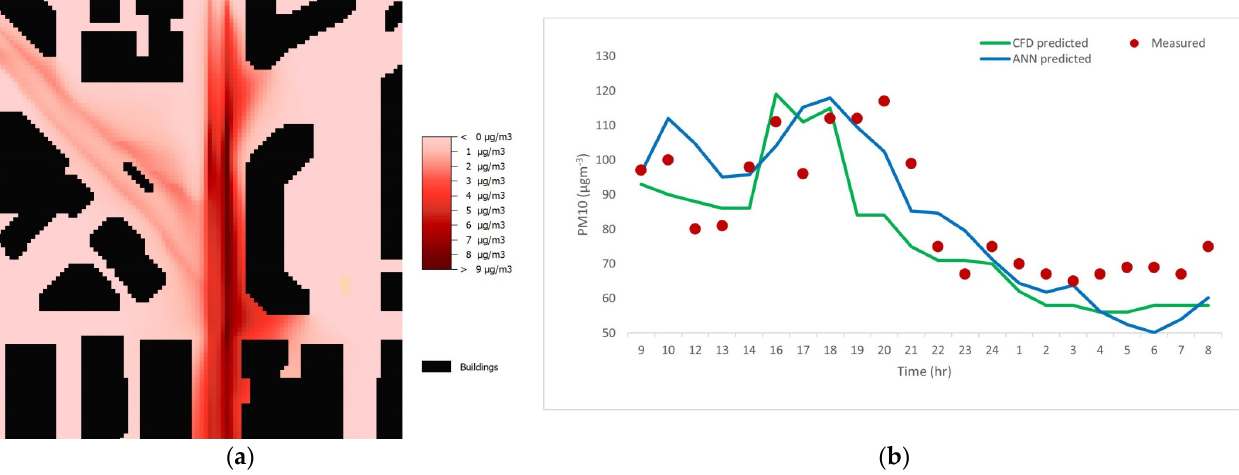
Figure 4. The CFD modeling results and comparison with the ANN modeling results and measure- ments. ( a ) Sample-predicted distribution of PM 10 enhancement due to traffic (1.5 m above ground) by the CFD model during peak hours. ( b ) Comparison of the predicted PM 10 diurnal variations by the CFD model and the ANN model. The measured data are shown as circles. Table 3. Summary of model performance.